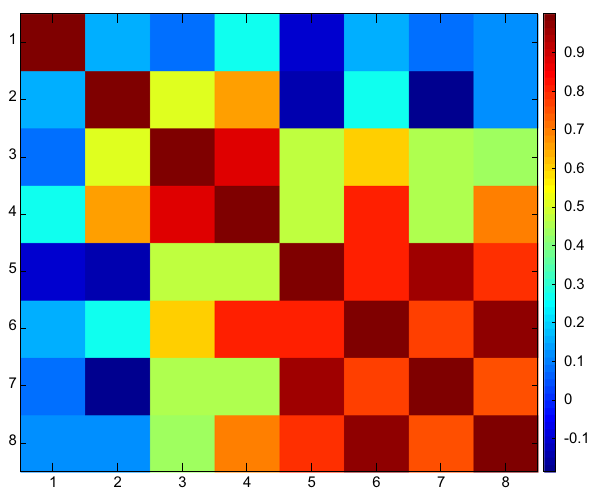
Fig. 2 Correlation of ash fusibility temperature